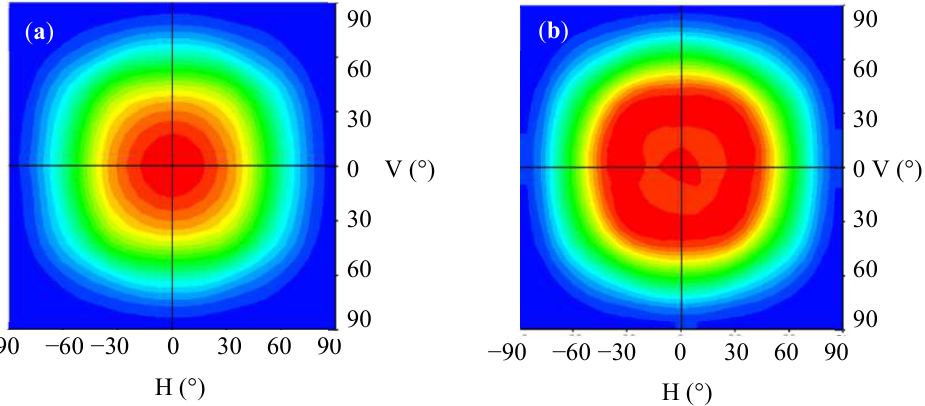
Figure 15. Plane rectangular light distribution curves of the light guide layer unit module combined with a diffusion film: ( a ) without concave PSMLAs; ( b ) with concave PSMLAs.